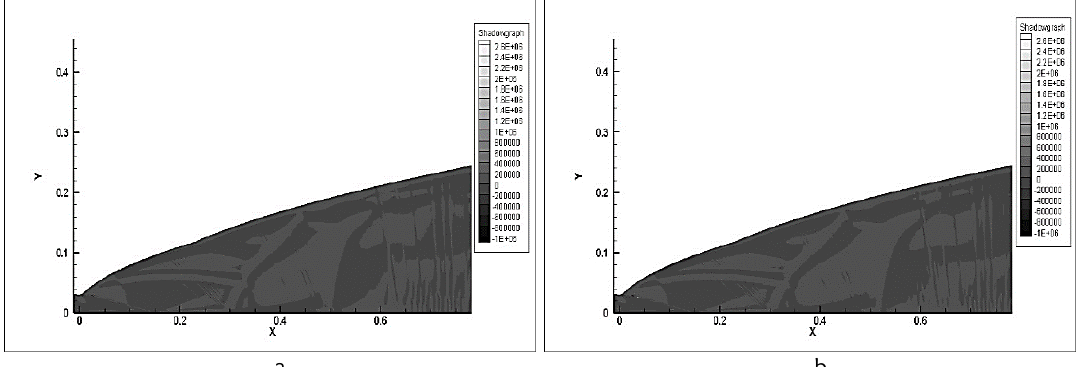
Figure 9: Schlieren image or shadowgraph for pressure ratio 50 (a) and 100